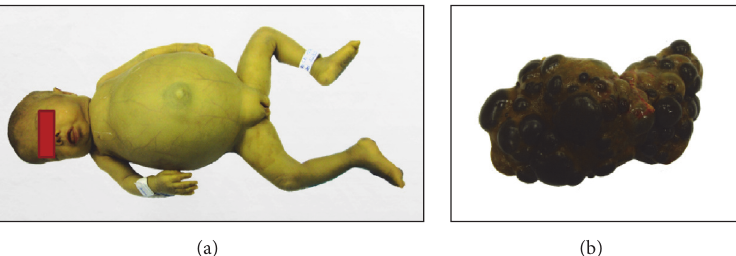
Figure 3: (a) Overview of the patient. (b) Macroscopic view of the liver at autopsy. Analysis of the liver showed multiple nodules in the parenchyma, causing architectural distortion.